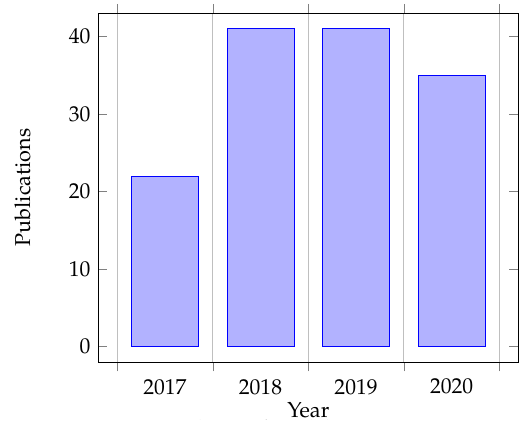
Figure 2. Number of publications per